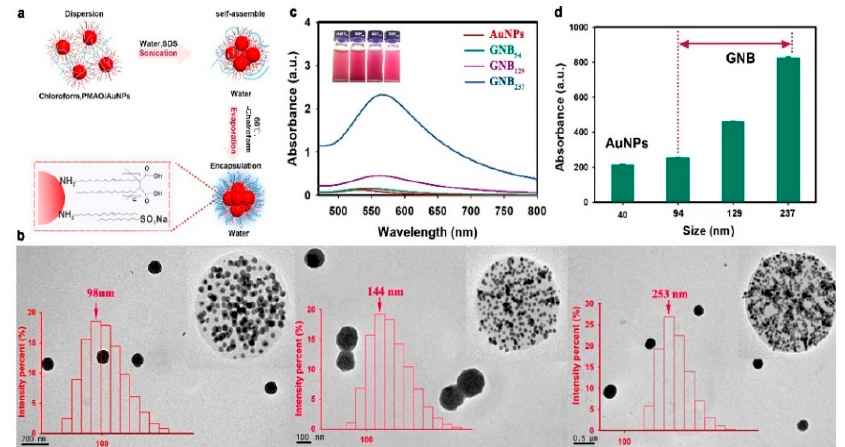
Figure 1. ( a ) The synthetic route of the designed GNBs. ( b ) TEM images and DLS measurement. ( c ) UV-vis absorption spectra of GNB 94 , GNB 129 , GNB 237 , and AuNP 40 . ( d ) Comparison of the OD values by spraying the GNB 94 , GNB 129 , GNB 237 , and AuNP 40 on the NC membrane as the T lines at the same molar concentrations.